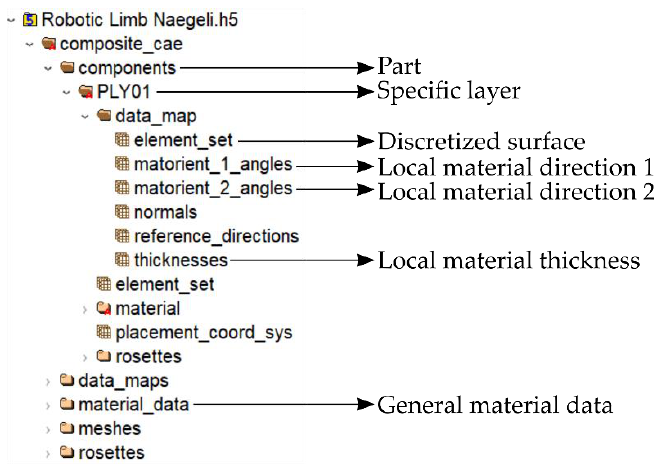
Figure 9 . HDF5 file structure with discrete data on material and geometry.